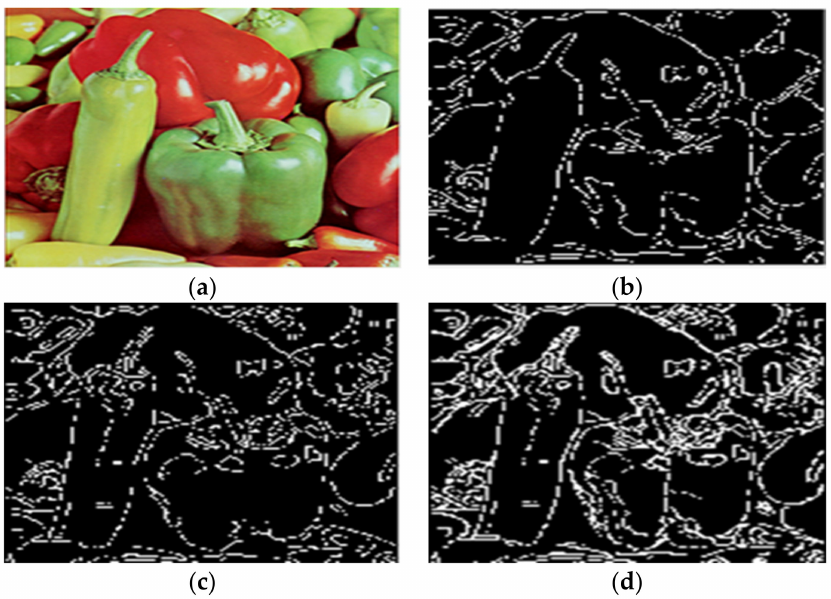
Figure 9. Comparison of segmentation results of Peppers by different algorithms. ( a ) The original image. ( b ) The water division lines were obtained by the algorithm in this paper. ( c ) The water division lines were obtained by the algorithm in [11]. ( d ) The water division lines were obtained by the algorithm in